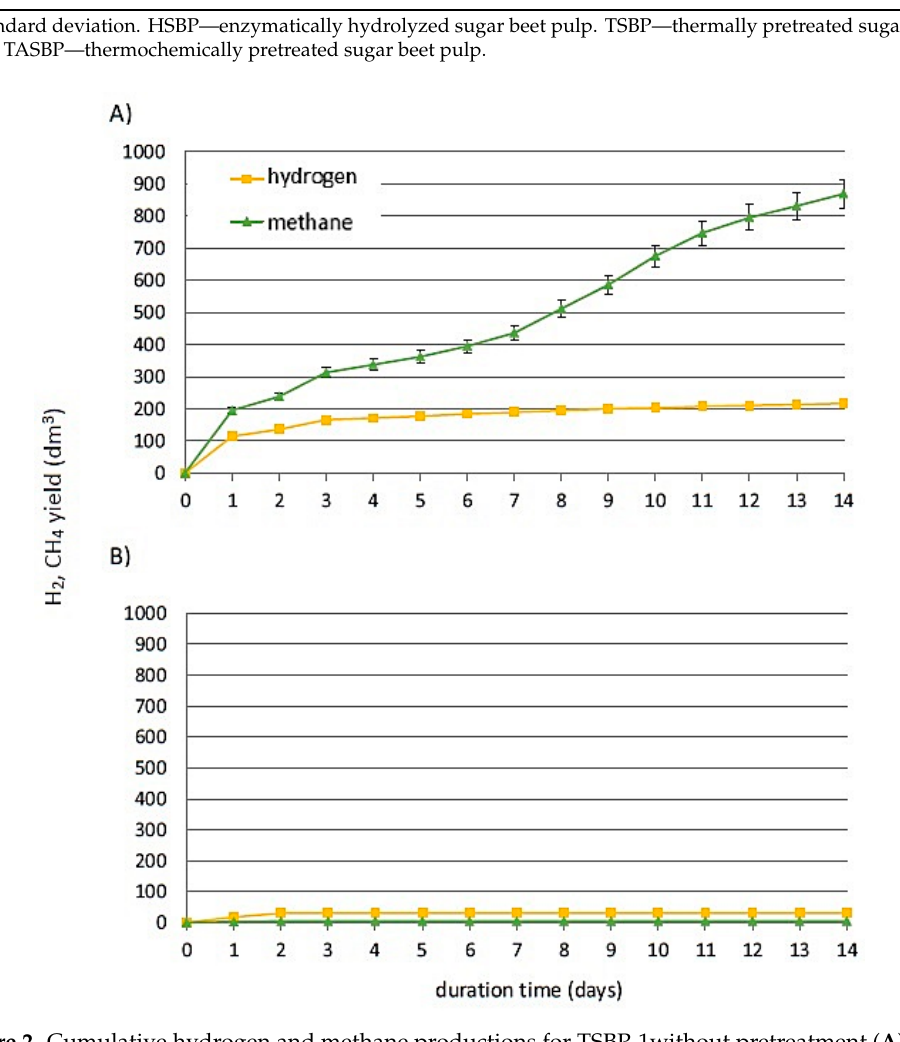
Table 3. Parameters of the batch digestion tests with pH adjustment and thermal pretreatment.